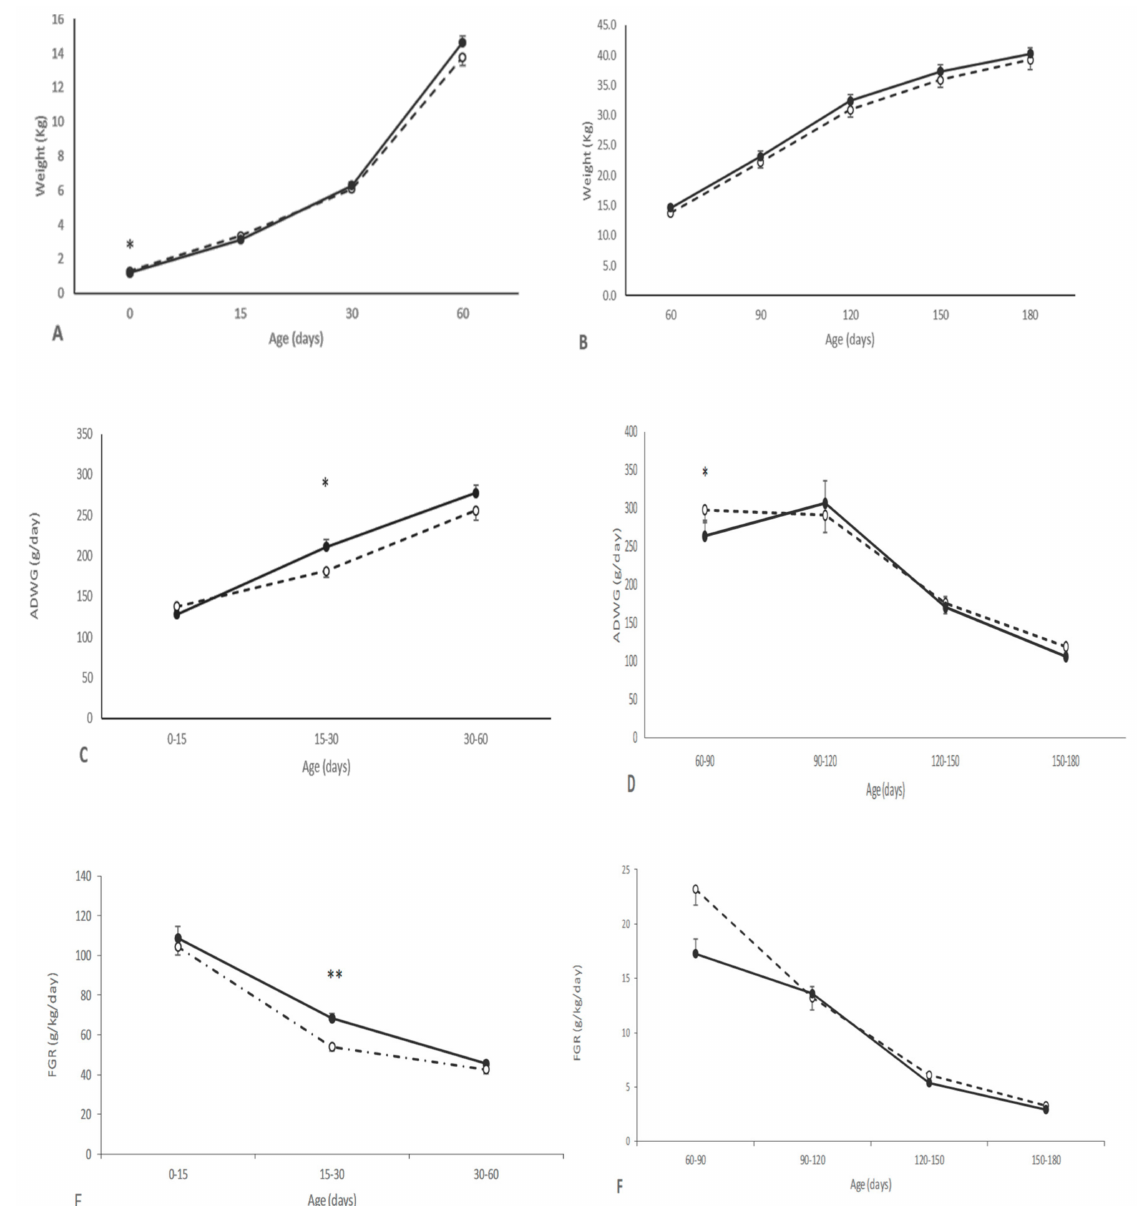
Figure 1. Changes over time in mean values ( ± S.E.M.) of body weight ( A–B ), average daily weight gain (ADWG; panels ( C , D )) and fractional growth rate (FGR; E–F ), during early postnatal (0 to 60 days-old; left panels) and juvenile periods (60 to 180 days-old; right panels), in piglets born from sows treated or not with hydroxytyrosol and linseed oil during pregnancy (groups T (black dots with continuous line) and C (white dots with discontinuous lines), respectively). Asterisks denote significant di ff erences between groups (* p < 0.05; ** p <